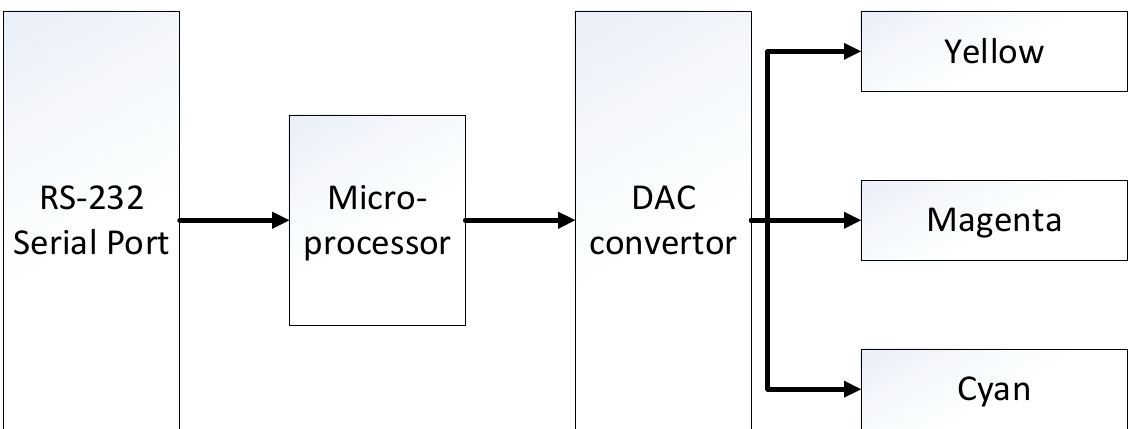
Figure 3. Schematic diagram of the full-color EWDs control system.